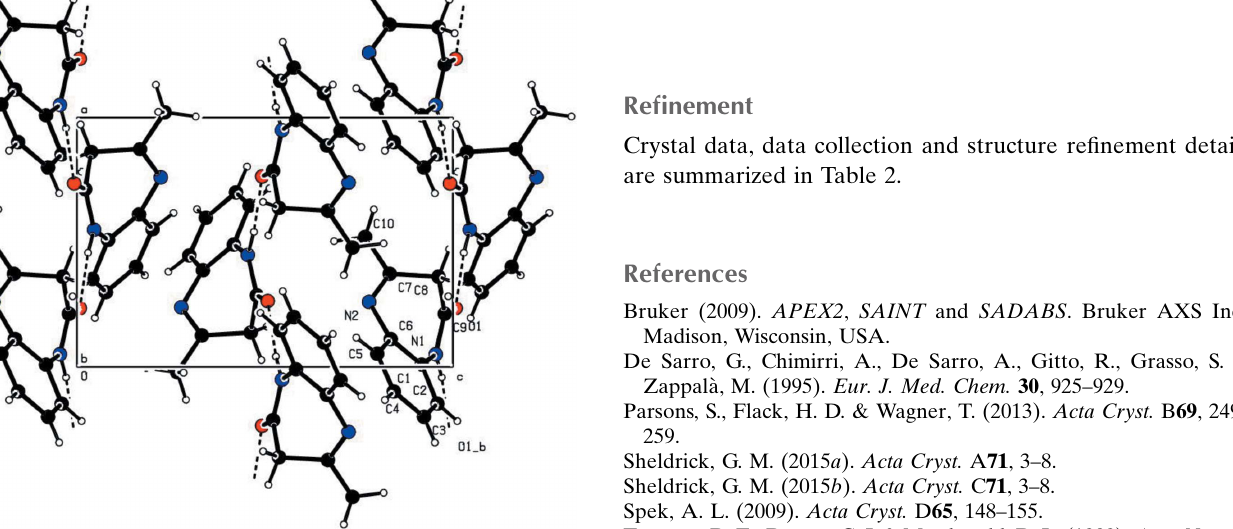
Figure 2 Structure of the title compound, showing molecules linked through N— H (cid:2)(cid:2)(cid:2) O and C—H (cid:2)(cid:2)(cid:2) O hydrogen bonds (dashed